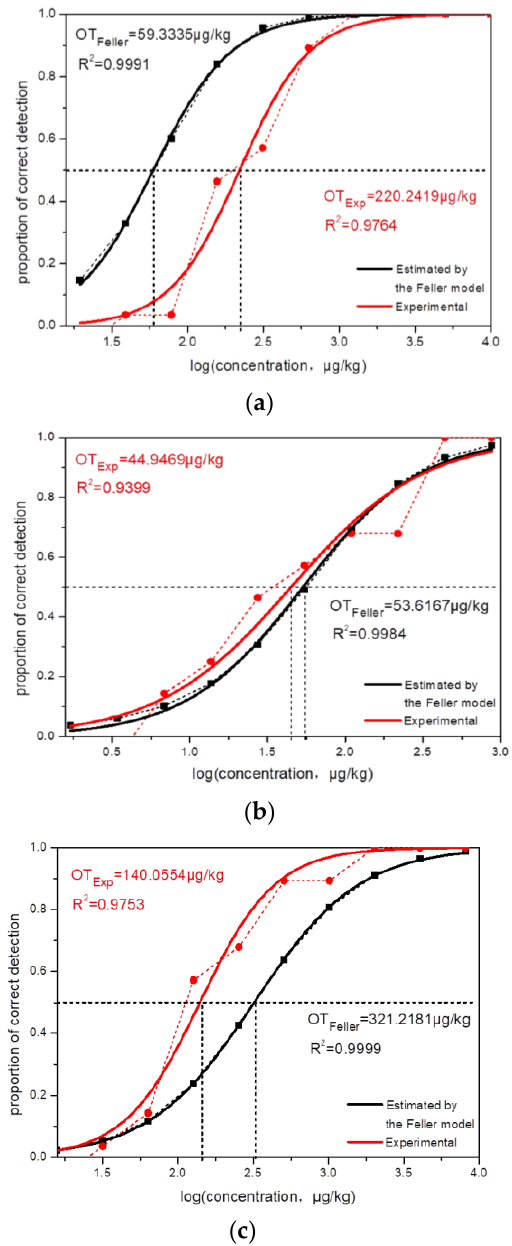
Figure 2. Interactions between methyl salicylate and floral compounds: ( a ) MeSA + phenylacetaldehyde, masking effect, ( b ) MeSA + cis-jasmone, addition Effect. ( c ) MeSA + benzyl alcohol, synergistic effect.